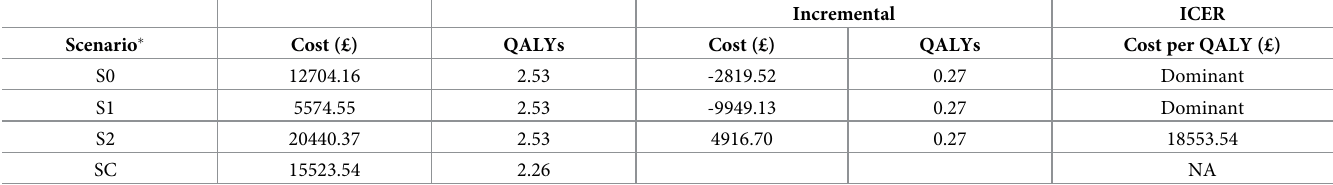
Table 7. Cost-effectiveness results for FlowOx ™ therapy (one dose per annum) compared to standard care over five